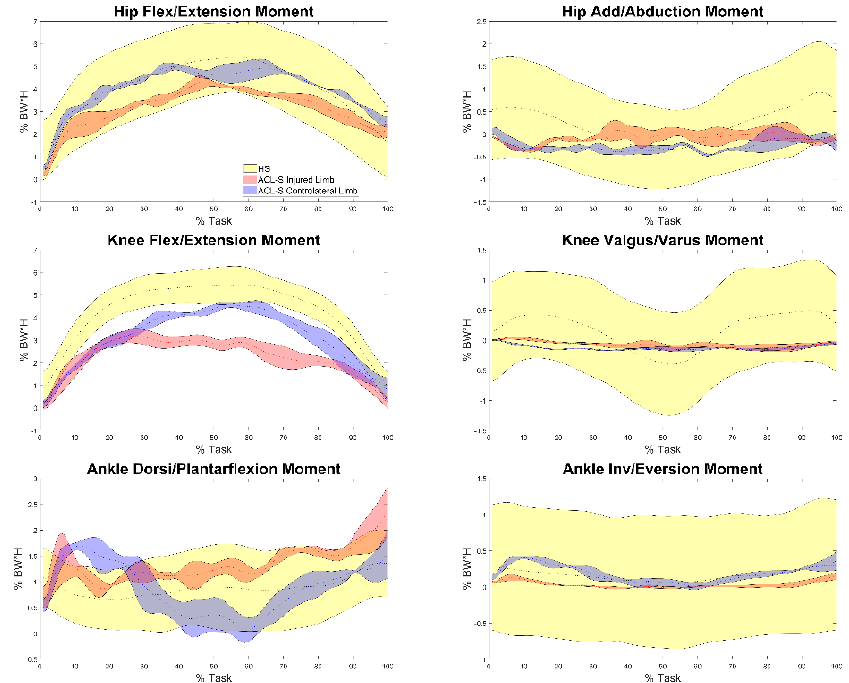
Figure A2. Hip, knee and ankle adduction/abduction and flexion/extension moments, calculated through the Ground Reaction Vector approach: HS (yellow), ACL ‐ S injured limb (red) and ACL ‐ S contralateral limb (blue). Average plus and minus one standard deviation are reported as coloured bands.